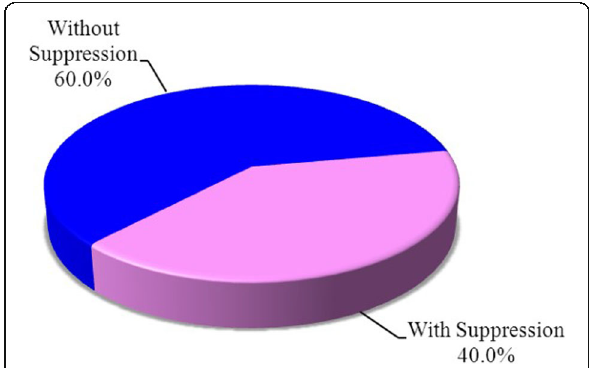
Fig. 1 Percentage of DPOAE suppression in tinnitus ears (according to suppression